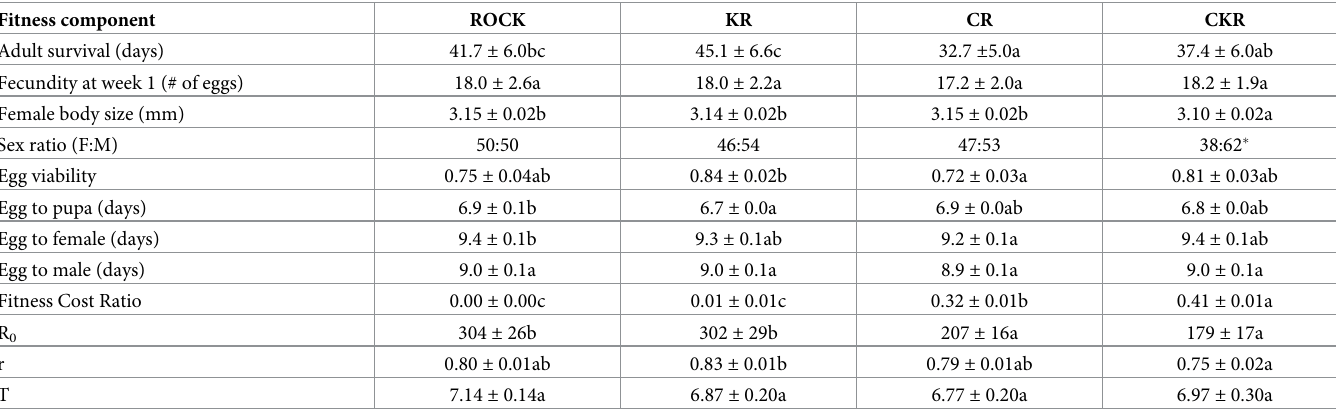
Table 4. Fitness components in congenic strains of A . aegypti . Values represent the mean ± SE except for sex ratio (percent female to